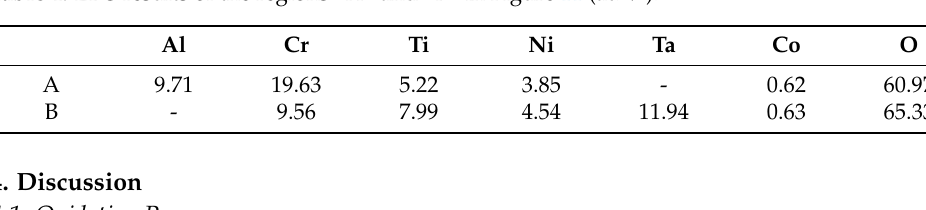
Figure 12. Secondary electron micrograph and the corresponding X-ray micrograph of the E75 alloy after oxidation at 1000 °C for 500 h. Table 4. EDS results of the regions “A” and “B” in Figure 11 (at. %).